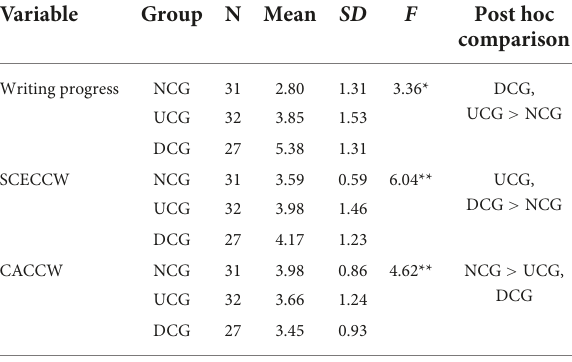
TABLE 1 Summary of writing progress, self-confidence enhancement and cognitive anxiety.